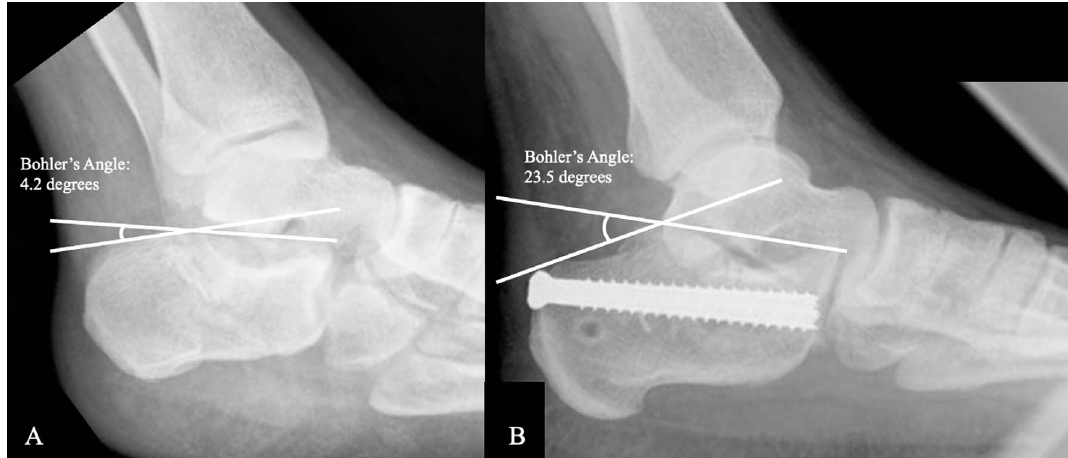
Figure 1. (A) Preoperative lateral foot radiograph of joint depression-type calcaneal fracture. Bohler ’ s angle measured 4.2 degrees through intersecting lines tangential to the superior tuber and the superior aspect of the posterior facet, and the superior aspect of the posterior facet and the anterior calcaneal process. In (B) a postoperative lateral foot radiograph is shown status post closed reduction with percutaneous fi xation with two cannulated, fully threaded 6.5 mm screws with restoration of Bohler ’ s angle measuring 23.5 degrees.